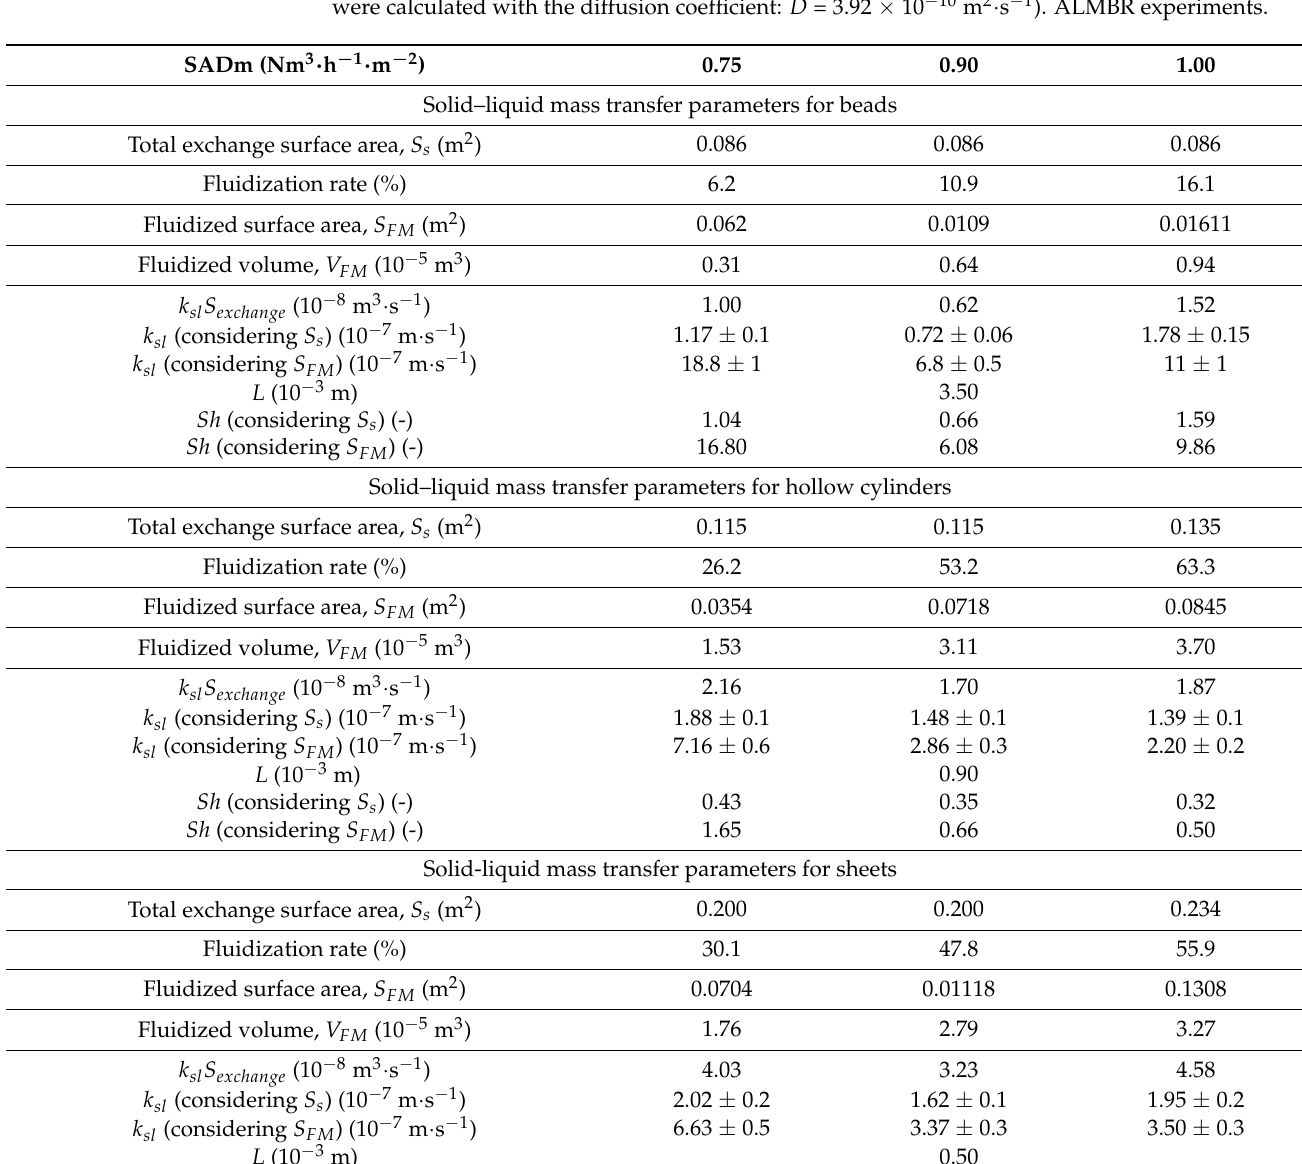
Table 7. Parameters of the mass model and Sherwood numbers for the solid–liquid mass transfer of Rose Bengal lactone from the medium to the liquid, under different air flowrates (The Sh numbers were calculated with the diffusion coefficient: D = 3.92 × 10 − 10 m 2 · s − 1 ). ALMBR